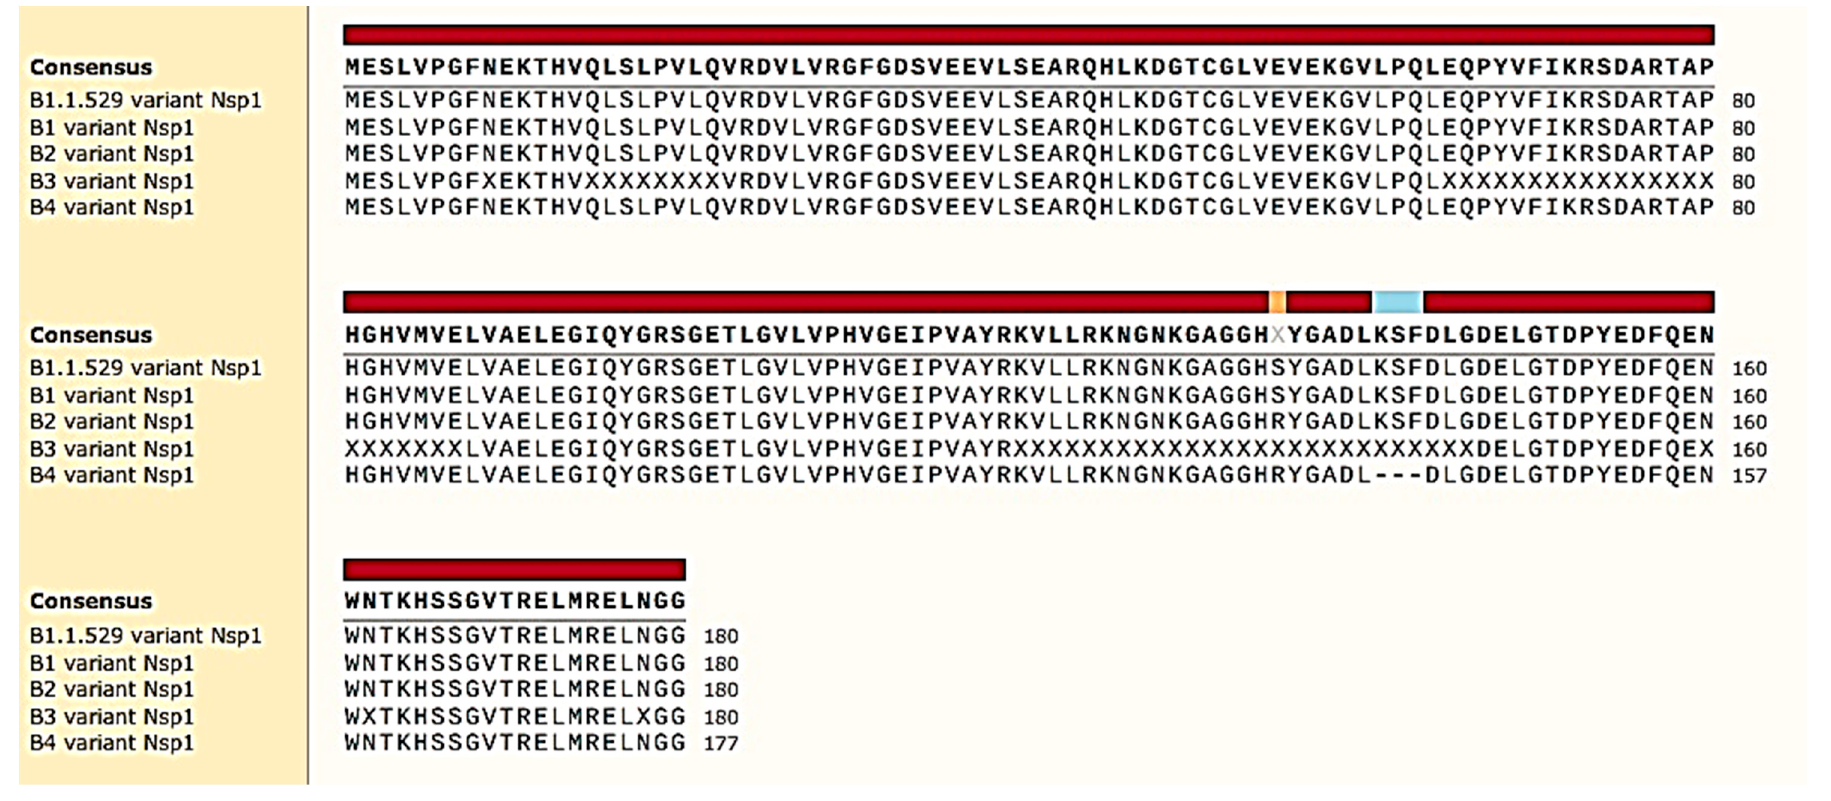
Figure 2. Pictogram of SNAPgene alignment of nsp1 protein portion of ORF1ab protein among Omicron lineages. KSL141_del is in light blue.